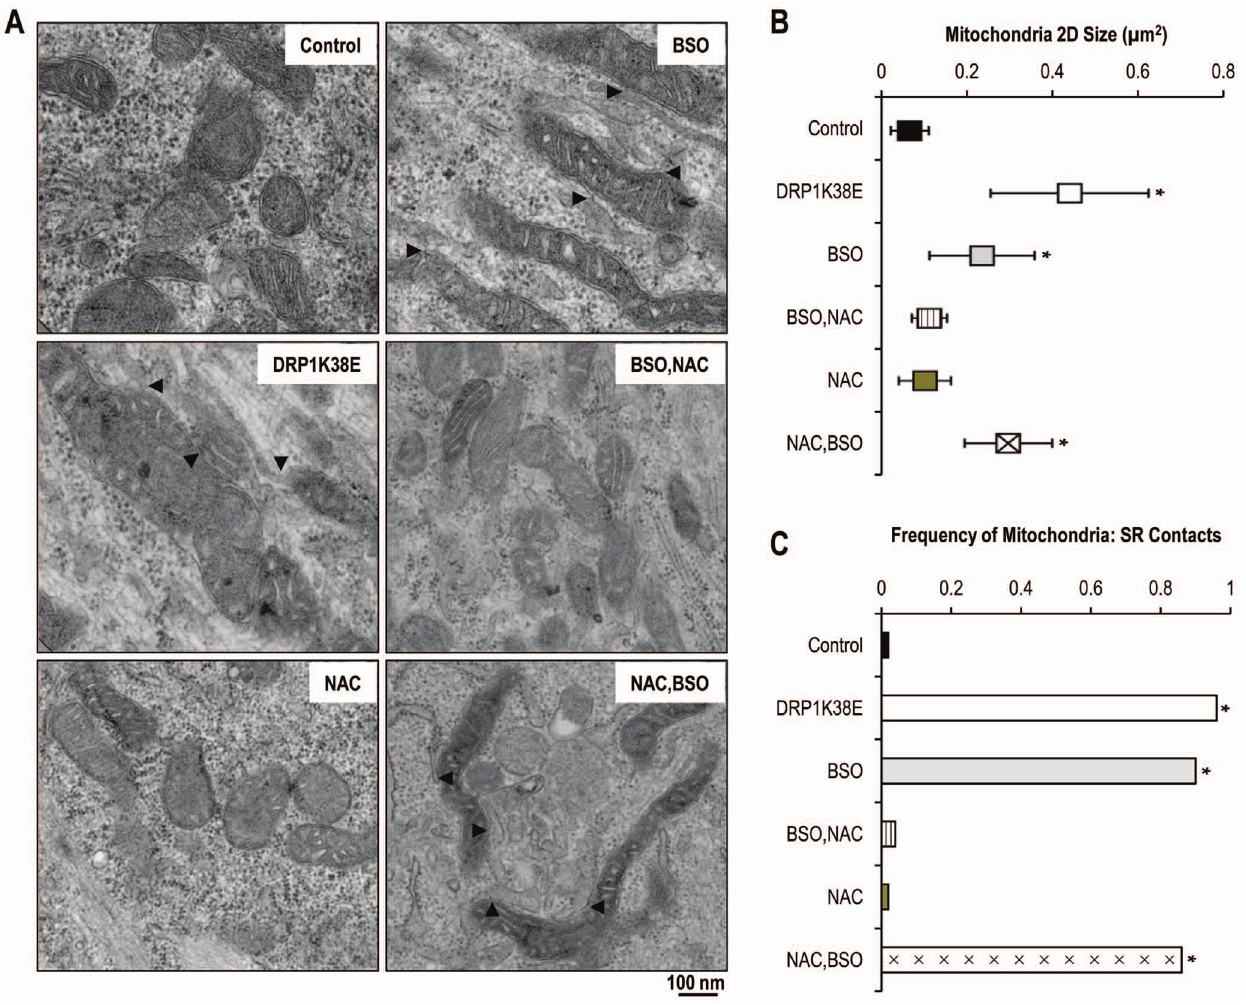
Figure 5. DRP1K38E expression and oxidative stress promote mitochondrial fusion, SR colocalisation and increased SR:mitochondrial contacts. C2C12 myoblasts were induced to differentiate for 48 h and then were infected with DRP1K38E or treated with BSO or NAC. No treatment or empty adenoviral vectors served as control. Panel A: Representative electron microscopy images (x15000) of C2C12 myotubes expressing DRP1K38E or having been incubated with BSO, NAC or both. Arrowheads mark mitochondria-ER association sites. Panel B: Objective mean quantitative data for mitochondrial 2D area on 2-D electron microscopy. Panel C: Objective mean quantitative data for the occurrence of visible MAM on 2-D electron microscopy. * Denotes p , 0.001 ANOVA and Fisher ’ s exact test , n=50 all